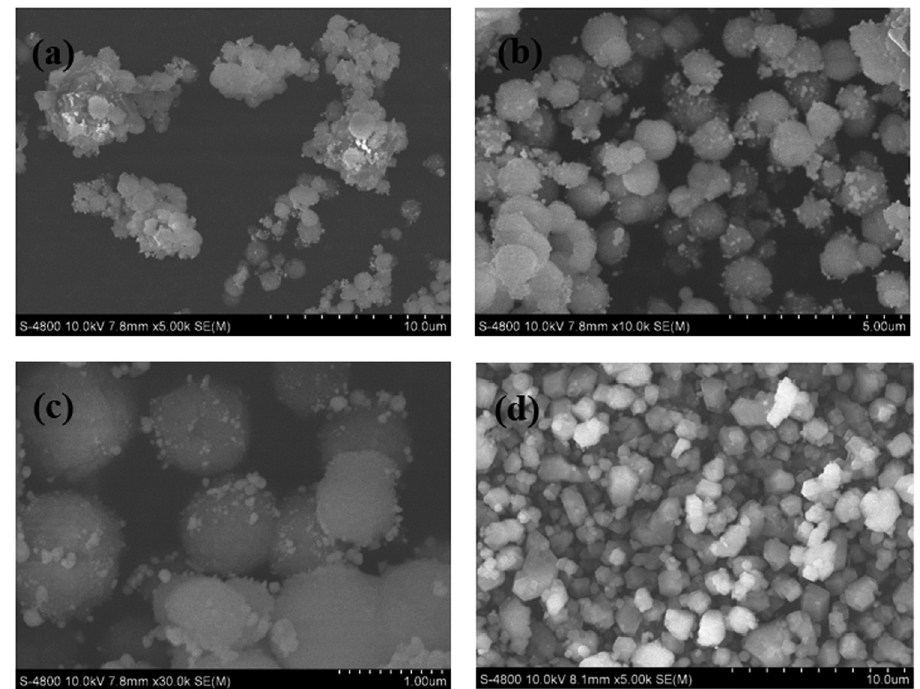
Figure A3: EDX spectra of ( a ) ZnCo - ZIFs and ( b ) Ag/ZnCo -